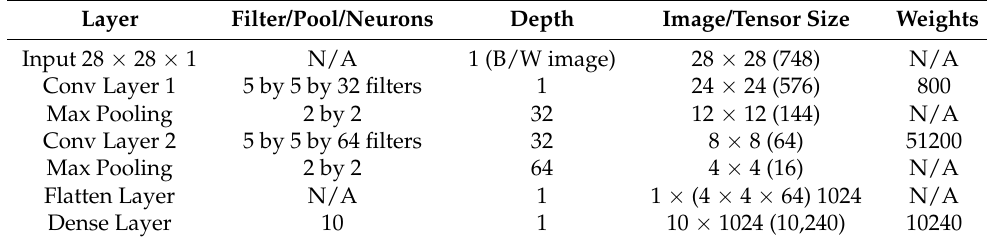
Table 1. Weights and image size parameters in each layer of the benchmark model by Torres. Layer Filter/Pool/Neurons Depth Image/Tensor